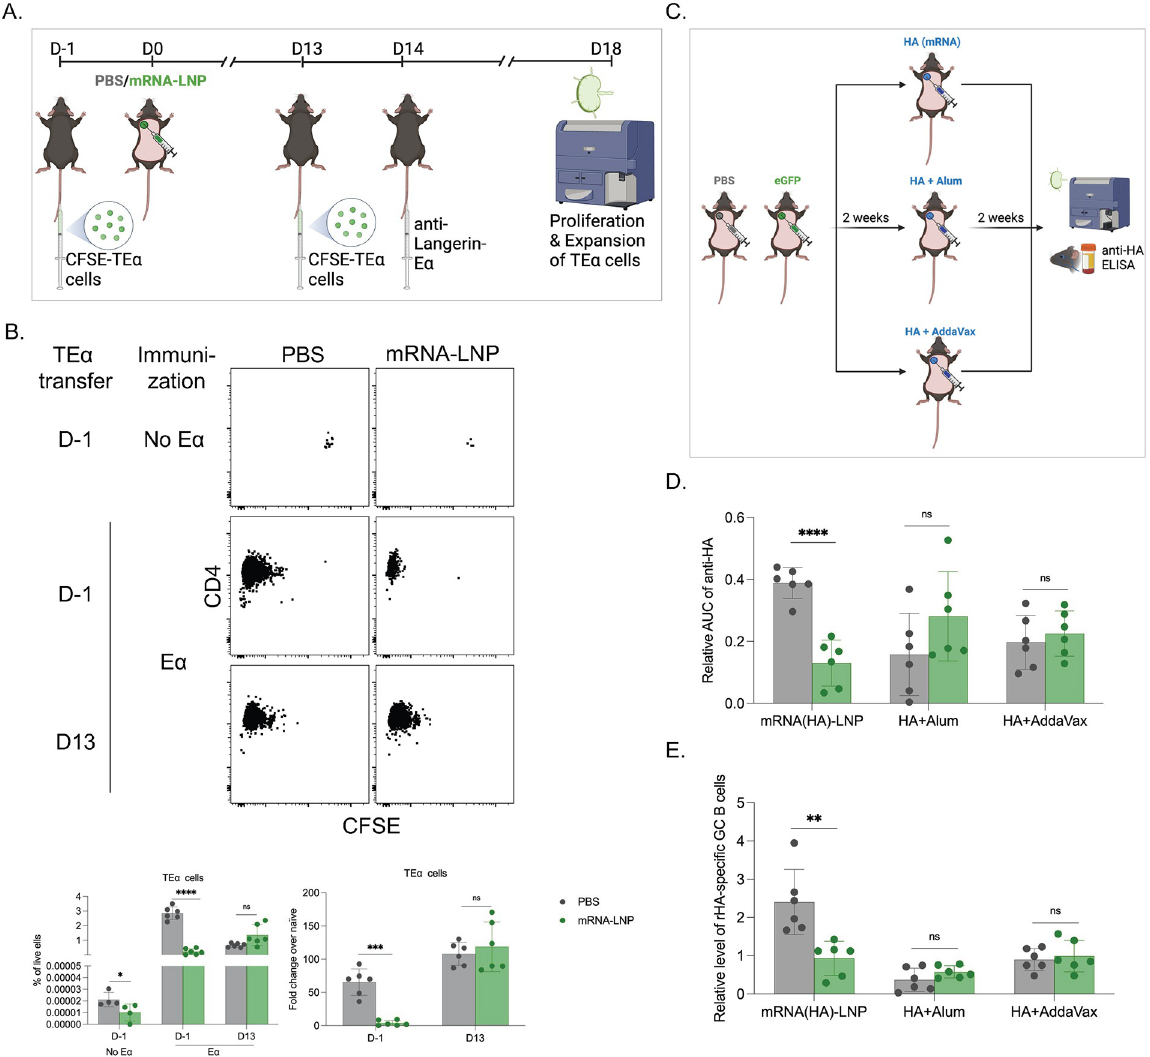
Fig 4. The general inhibition of adaptive immune responses induced by pre-exposure to mRNA-LNP can be overcome with the use of adjuvants. A). Experimental model. CFSE-labeled TE α cells were transferred 1 day before (D-1) or 13 days after (D13) exposure to PBS or mRNA-LNP coding for eGFP. Anti-Langerin-E α peptide was intravenously delivered on D14. The mice were sacrificed and the SDLNs were harvested for TE α cells examination by flow cytometry. B ). Representative flow plots of TE α cell responses with/out E α peptide stimulation (top), and the correspond summary graphs (bottom) on % of TE α cells in live cells and the fold change of expanded TE α cells over the non- immunized controls. C ). Experimental model. Two weeks post-exposure to PBS or eGFP mRNA-LNP the animals were injected into the same spot with PR8 HA mRNA-LNP, or HA protein mixed with Alum or AddaVax. The anti-HA responses were assessed as depicted two weeks later. D ). Summary AUC graph on serum anti-HA antibody levels. E ). Relative GC B cell responses from the same mice. Each dot represents a separate mouse. Data from at least two separate experiments pooled and are shown as mean ± SD. Welch’s t test was used to establish significance. ns = not significant. �� p < 0.005, ��� p < 0.0005, ���� p < 0.0001. Figures were drawn by the authors using BioRender.